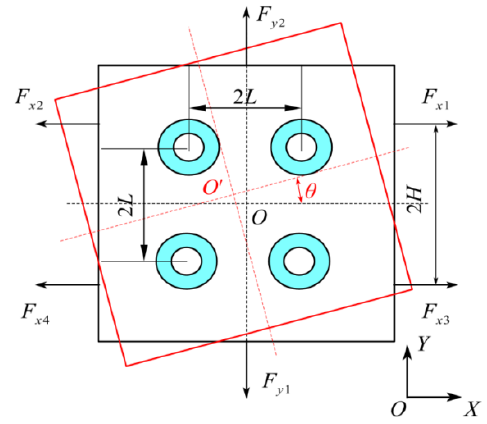
Figure 5. Force and motion of the platform.